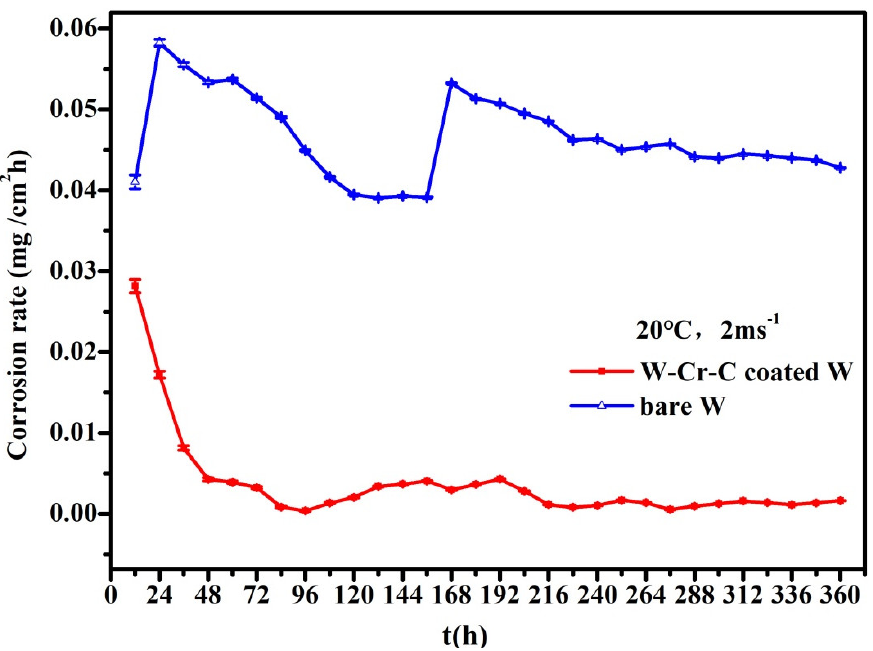
Figure 3. Variation of the corrosion rate with time for samples at the velocity of 2 ms −1 under the water temperature of 20 °C.